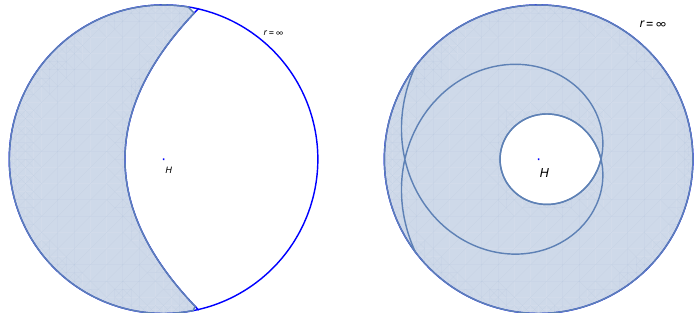
Figure 9 . Cases ( IIA (cid:0) ) and ( IIB (cid:0) ) have (cid:11) e negative at all r so that exterior solutions tend to spiral outward from r min . Left: in some cases the wall reaches the Euclidean AdS boundary without self-intersections. We may then keep the unshaded region and potentially build a smooth solution, depending on the interior. Recall that the interior imposes no restrictions in case ( IIA (cid:0) ), where interior solutions are as in case ( III ), shown at right in (cid:12)gure 6. Right: in other cases, one or more self-intersections occur before the wall reaches the Euclidean AdS boundary and smooth solutions do not